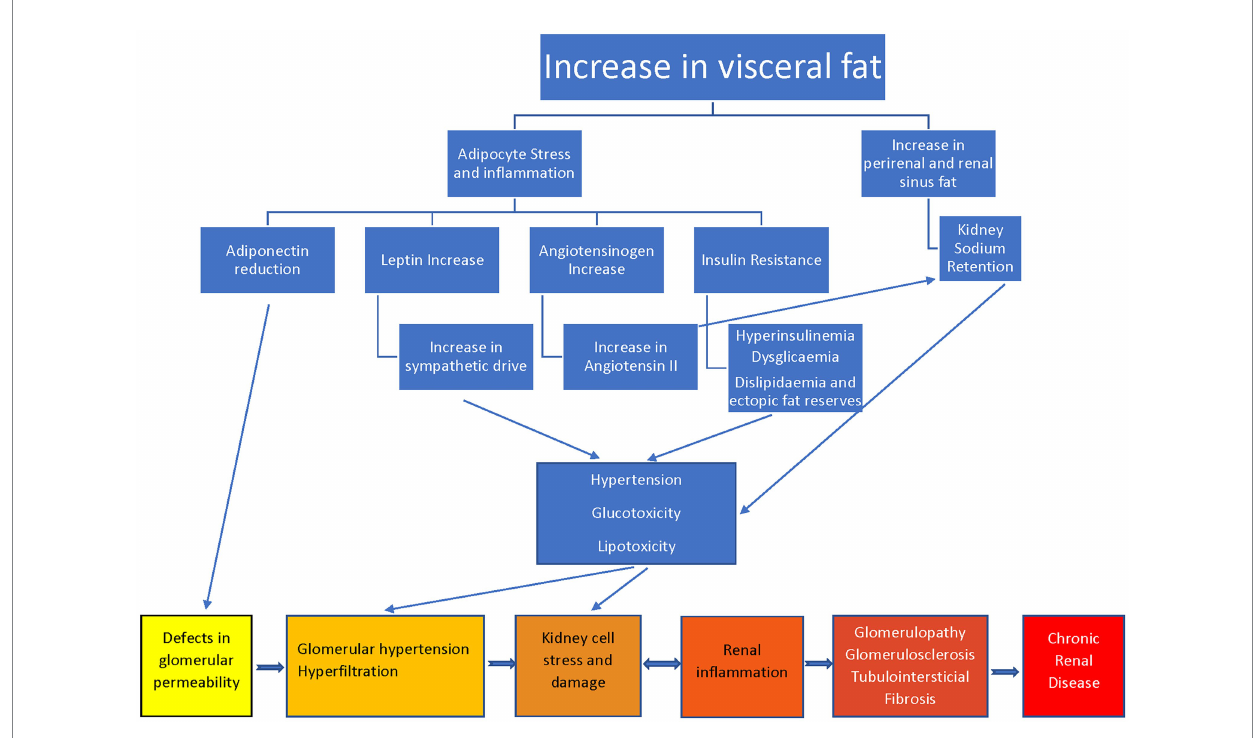
FIGURE 1 Pathophysiological mechanisms and consequences of obesity on the